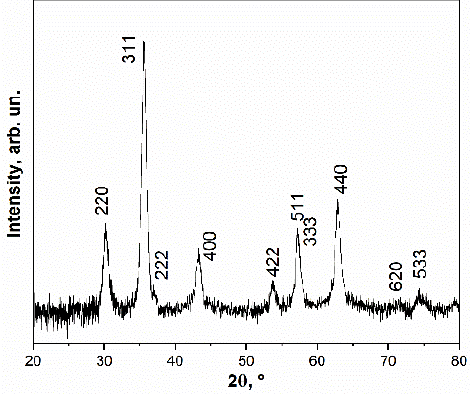
Figure 2. XRD pattern of nanoparticles.